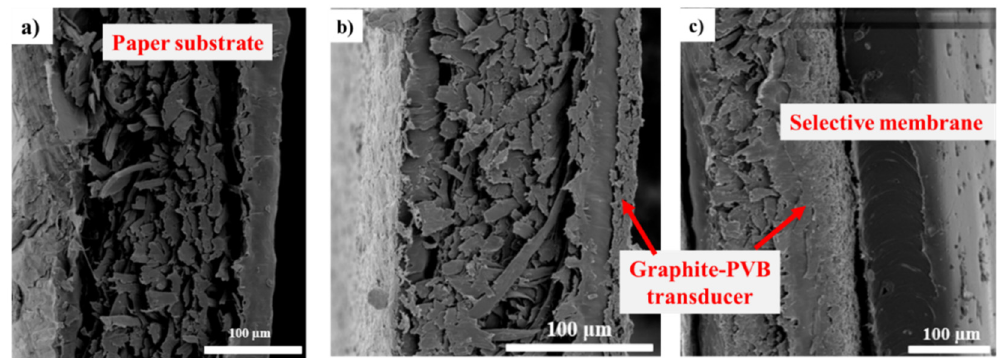
Figure 6. SEM cross-section images: ( a ) paper substrate with inkjet-printed silver line (500× magnification); ( b ) internal silver electrode coated with graphite-PVB solid-contact (500× magnification); ( c ) ammonium-selective membrane/graphite-PVB/silver electrode (300× magnification).